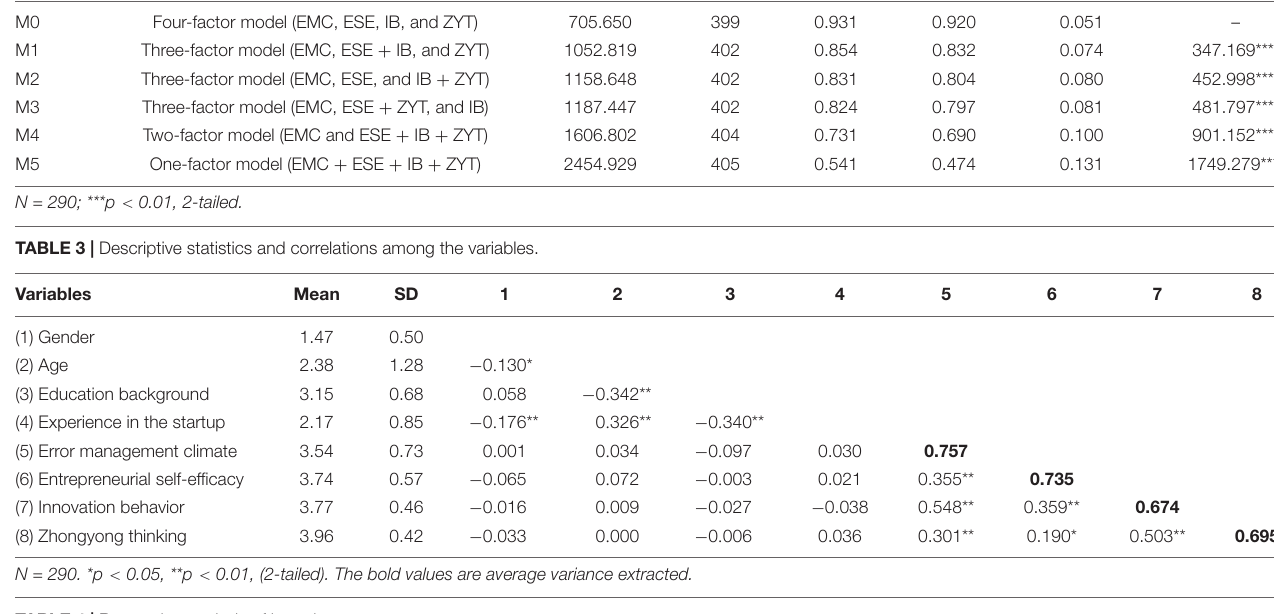
TABLE 4 | Regression analysis of